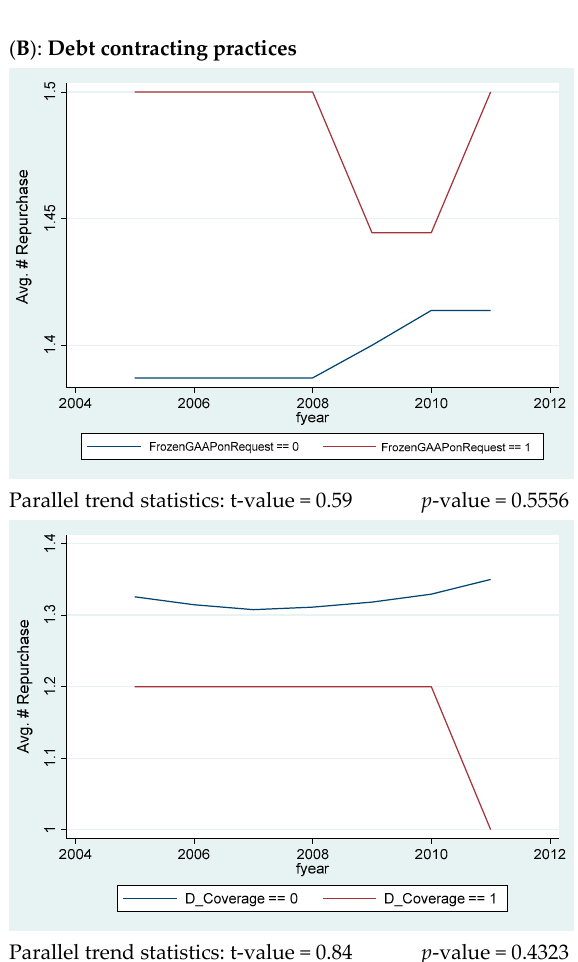
Figure 1. Trends in repurchase activities and parallel trends assumption.